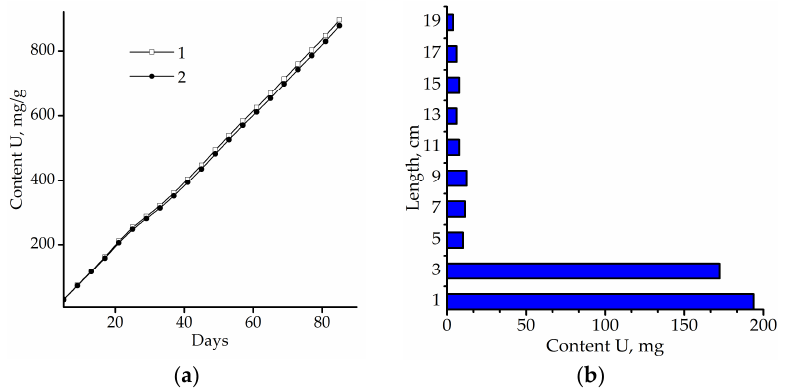
Figure 6. ( a ) Uranium released from contaminated water in column with ZVI2 and sand: 1—total uranium in the influent; 2—total released uranium; ( b ) Distribution of uranium in the reactive media in the column.